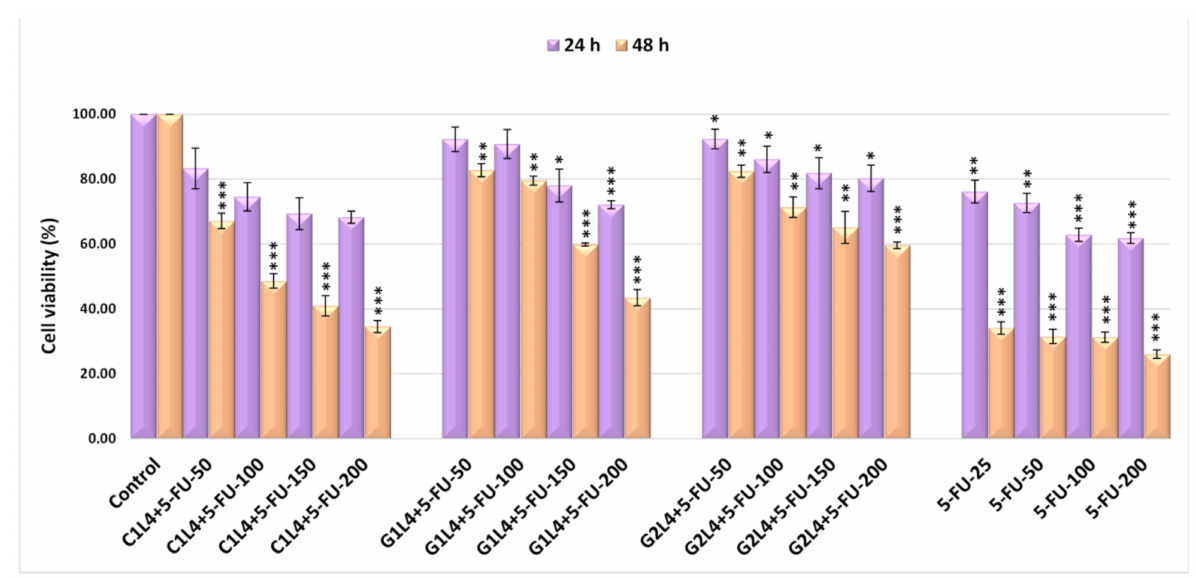
Figure 6. Effect of 24 and 48 h treatment, with different concentrations ( µ g/mL) of 5-FU and C1-L4, G1-L4 and G2-L4 complexes on the viability of TE 354.T neoplastic cell cultures (significance different from control: * p < 0.05, ** p < 0.01 and *** p <